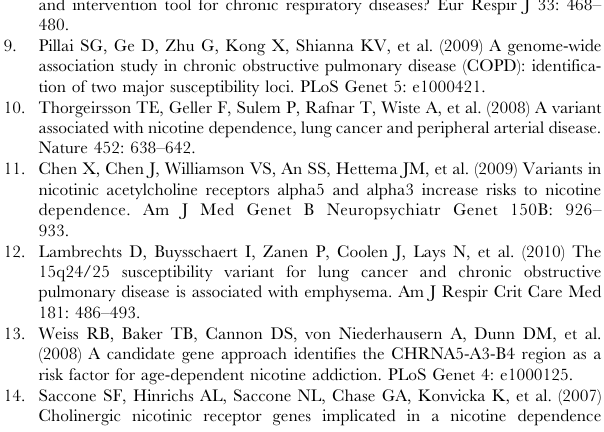
Figure S1 Linkage disequilibrium plot and correlation coefficients (r 2 ) for 3 polymorphisms in the nAChR cluster genotyped in Vlagtwedde-Vlaardingen cohort (n= 1,390). The location of the single nucleotide polymorphisms is given for the HapMap Data Release February 2009. (TIF) Table S1 Prevalence of the nAChR SNPs in Vlagtwedde – Vlaardingen. N= number of subjects. Table S2 The effect of the nAChR SNPs on smoking habits in smokers (pairs =3393) and ex-smokers (pairs = 1468). GEE model, adjusted for gender, time between 2 consecutive available visits; a = heterozygote vs. wild-type; b = homozygote variant vs. wild-type. Table S3 Annual FEV 1 declines in smokers and ex- smokers. Nr FEV 1 declines refers to the total number of annual FEV 1 declines available; Nr. subjects refers to smokers or ex- smokers who have at least 1 annual FEV 1 decline available. Table S4 Differences in annual FEV 1 decline according to smoking status. B= regression coefficient; LME model adjusted for gender, height and age at the first of two successive surveys and time between two successive surveys. The results showing a significant association are depicted in